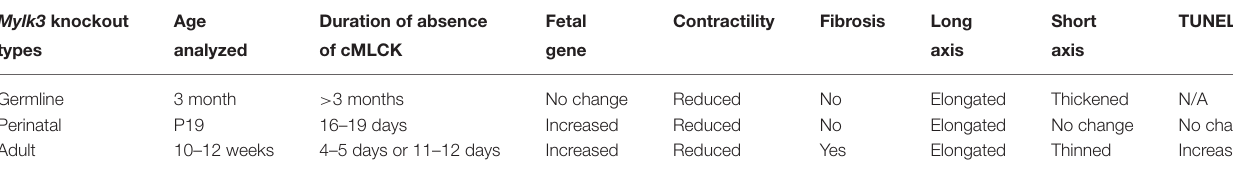
TABLE 1 | Summary of the phenotypes displayed in three Mylk3 knockout